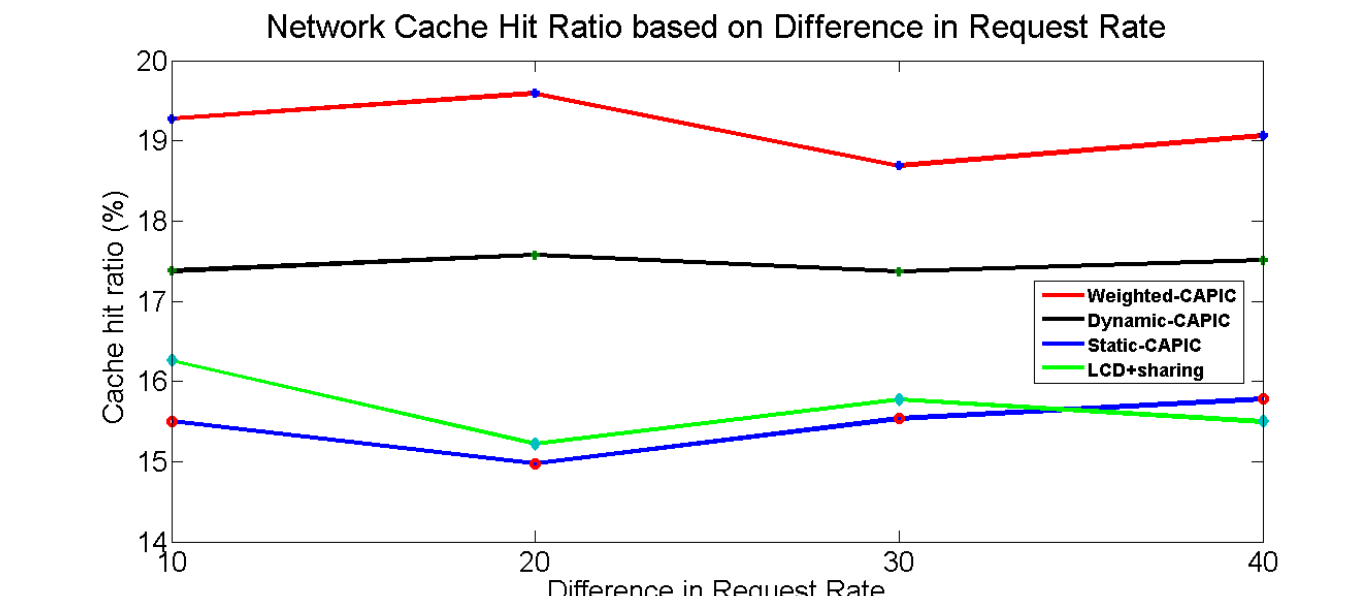
Figure 9. Network cache hit ratio for various request rate